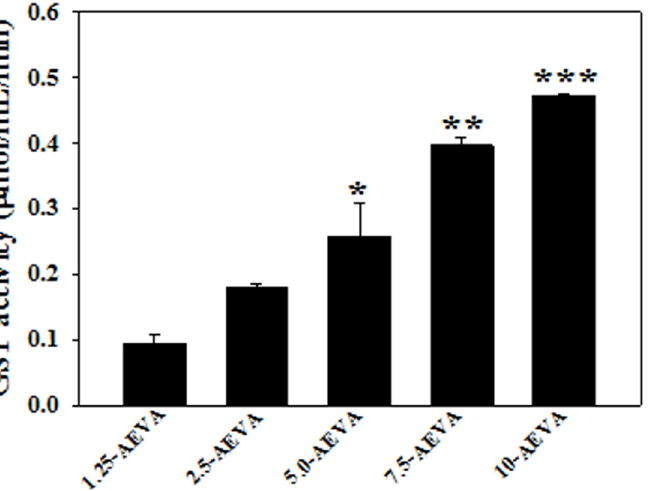
Fig 6. Dose dependent GST activity of AEVA. Graph is obtained by plotting different concentrations of AEVA (1.25, 2.5, 5, 7.5, and 10 μ g/ μ L) with respect to enzyme activity. “ * ” , “ ** ” , and “ *** ” indicate the significant differences between the effect of 5, 7.5, and 10 μ g/ μ L AEVA and its lower concentrations respectively ( p < 0.05). Values are mean ± SE (n = 4).